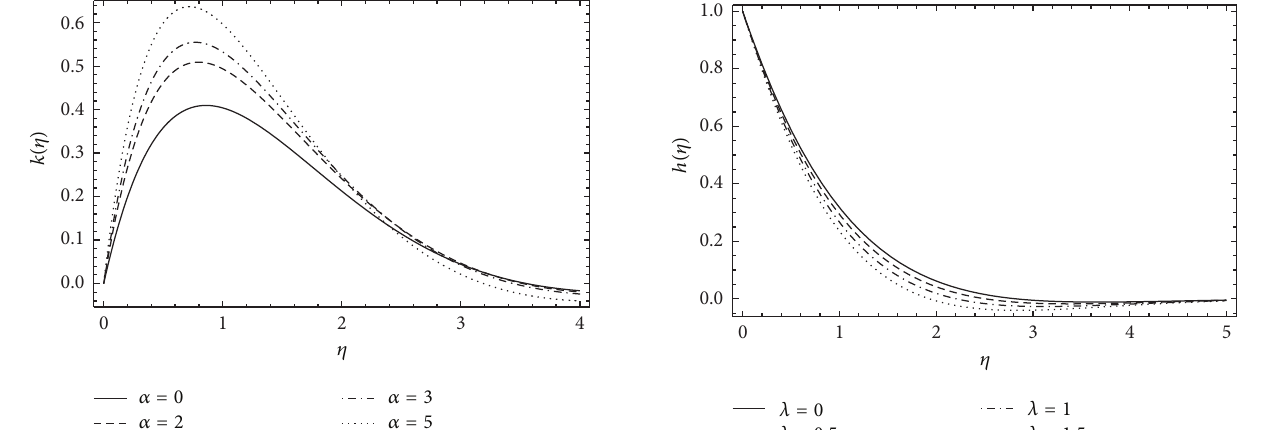
computation has been carried out by the homotopy analysis method and the influences of the pertinent parameters are investigated on the velocity profiles of the fluid in radial, azimuthal, and off-centered directions. Present investigation reveals that the couple stress parameter 𝜆 and disk rotational parameter 𝛼 have the same effect of increasing radial velocity and decreasing the remaining velocity functions with the increase in respective parameters. It can be concluded